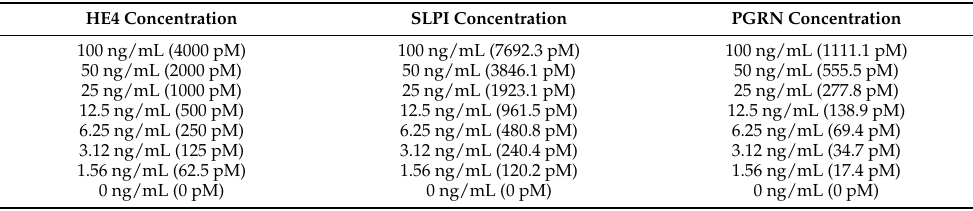
Table 6. Antigen dilution series for each Nb (dilutions in PBS and human